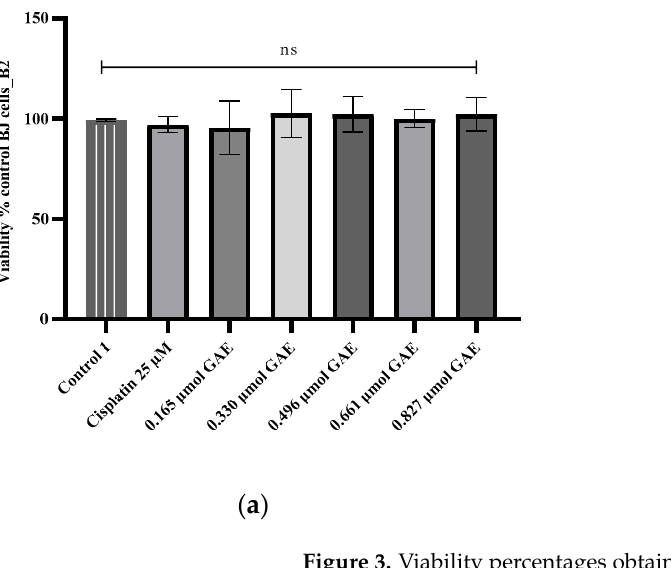
Figure 3. Viability percentages obtained for ( a ) BJ and ( b ) DLD-1 cells after 24 h incubation with B2 extract. The B2 concentrations were calculated according to the TPC µmol GAE (0.165–0.827 µmol GAE). Control 1 (negative control)—untreated cells; control 2—cells treated with cisplatin (25 µM). Data represent the mean ± SD of three independent experiments; ns—no significant differences; **— p < 0.05.